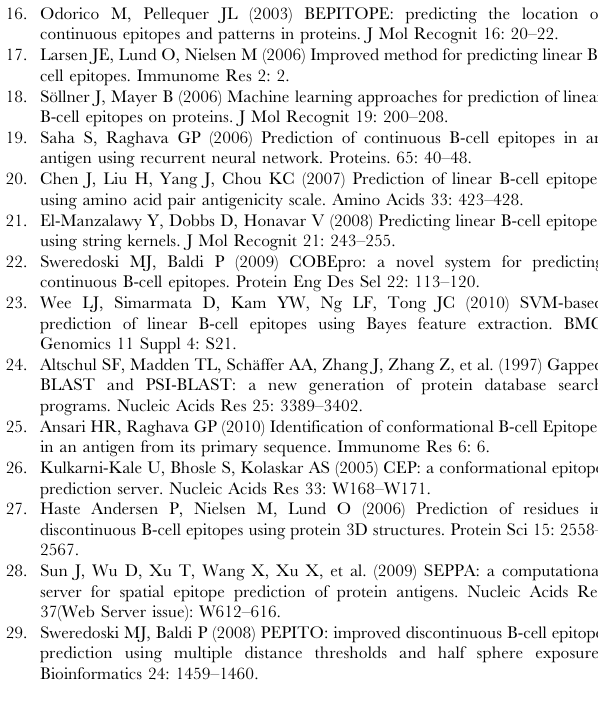
Table S1 List of the 84 selected features. The features are sorted according to the average (over the ten training folds generated based on the 10 fold cross-validation on the training dataset) absolute biserial correlation coefficient